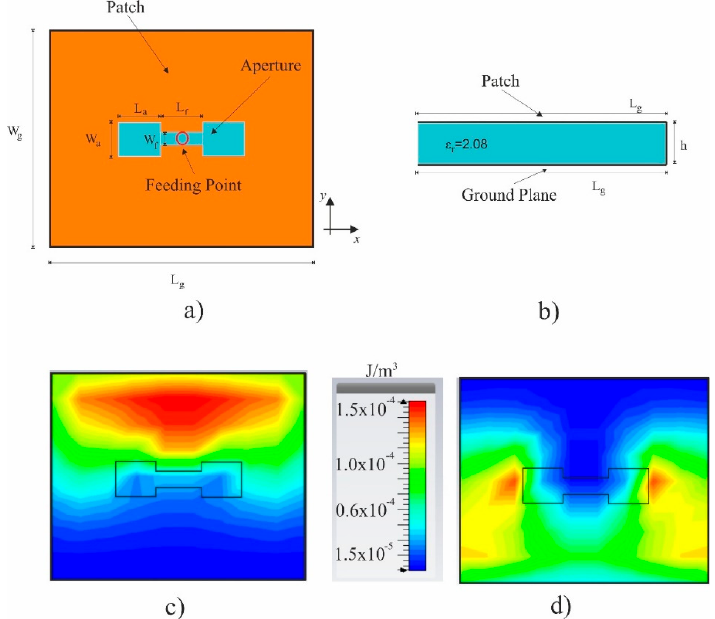
Figure 2. Front view ( a ), and lateral view ( b ) of the considered antenna. ( c ) Electric and ( d ) Magnetic energy densities close to the ground plane, at the resonant frequency. W g = 49 mm, L g = 60 mm, W a = 8 mm, L a = 10 mm, W f = 3 mm, L f = 10 mm, h = 4 mm.